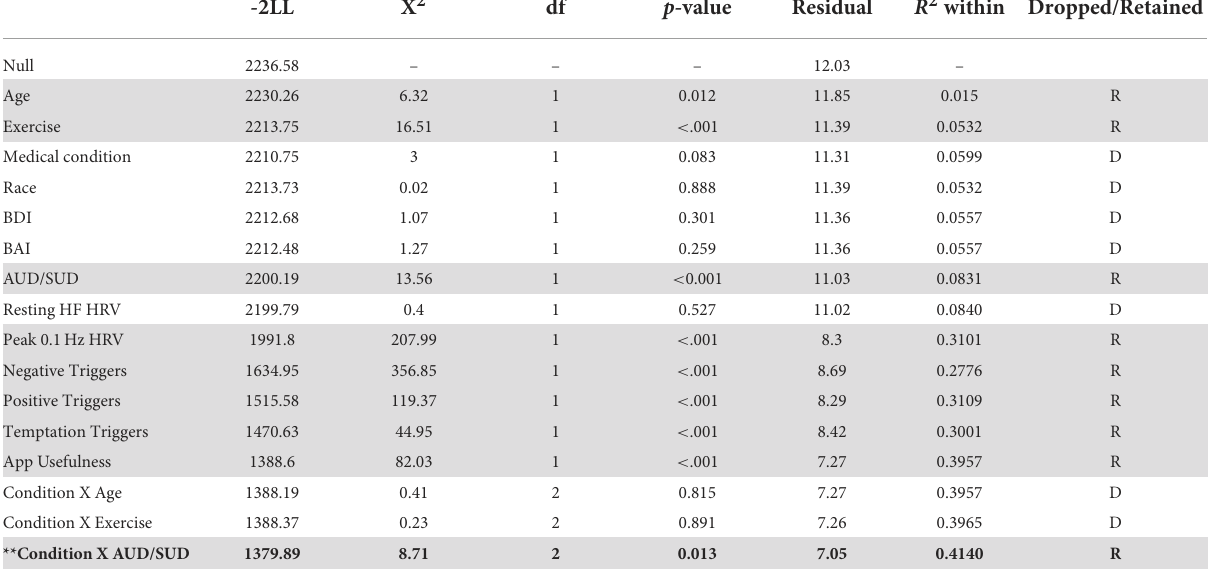
TABLE 1A Model fit statistics (compared to previous row): App use frequency.